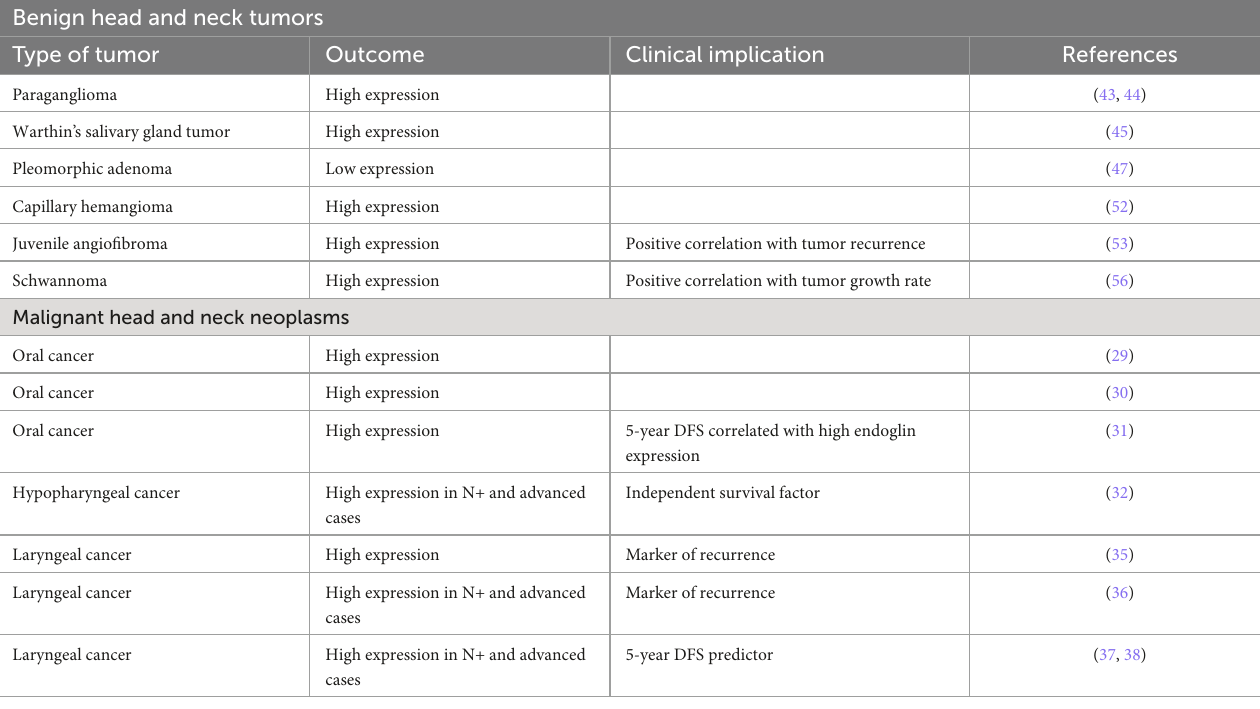
TABLE 1 The expression of endoglin in various benign and malignant head and neck tumors, reported in different